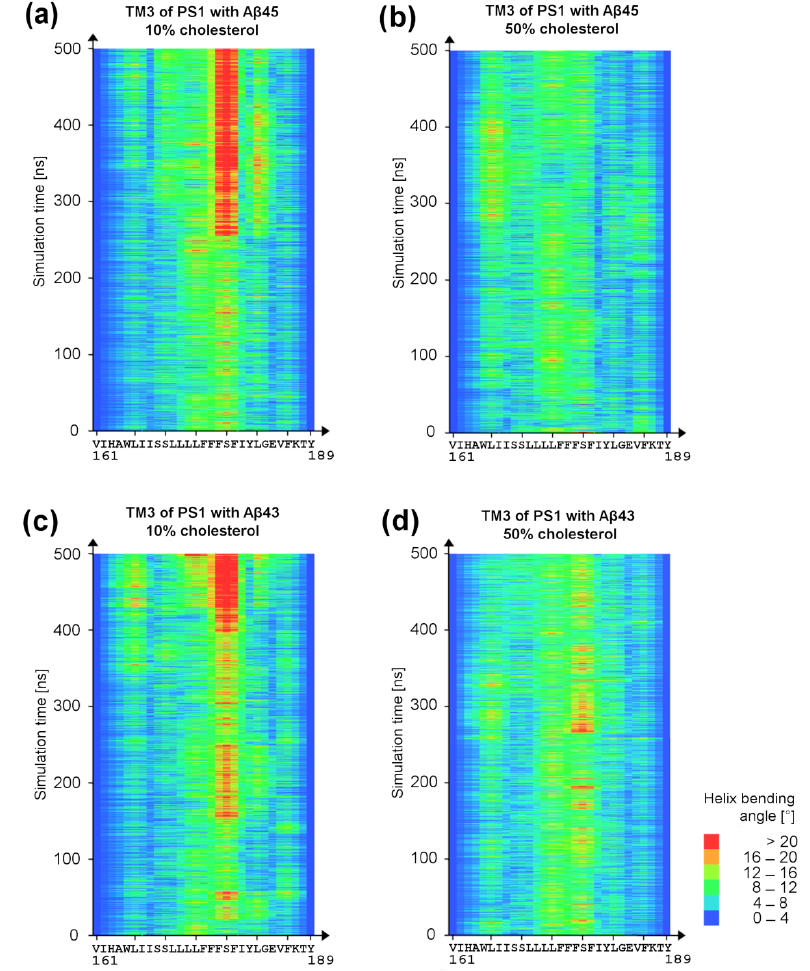
Figure 11. Bending of TM3 of PS-1 in low and high cholesterol concentrations in exemplary simu- lations. Helices TM2 and TM3 are in close contact with the substrate helix, and their positions can directly influence the position of the substrate at the binding site. ( a ) Bending angles at residues of TM3 PS-1 with A β 45 substrate in 10% cholesterol membrane; ( b ) the same in 50% cholesterol mem- brane; ( c ) bending angles at residues of TM3 PS-1 with A β 43 substrate in 10% cholesterol membrane; ( d ) the same in 50% cholesterol membrane.